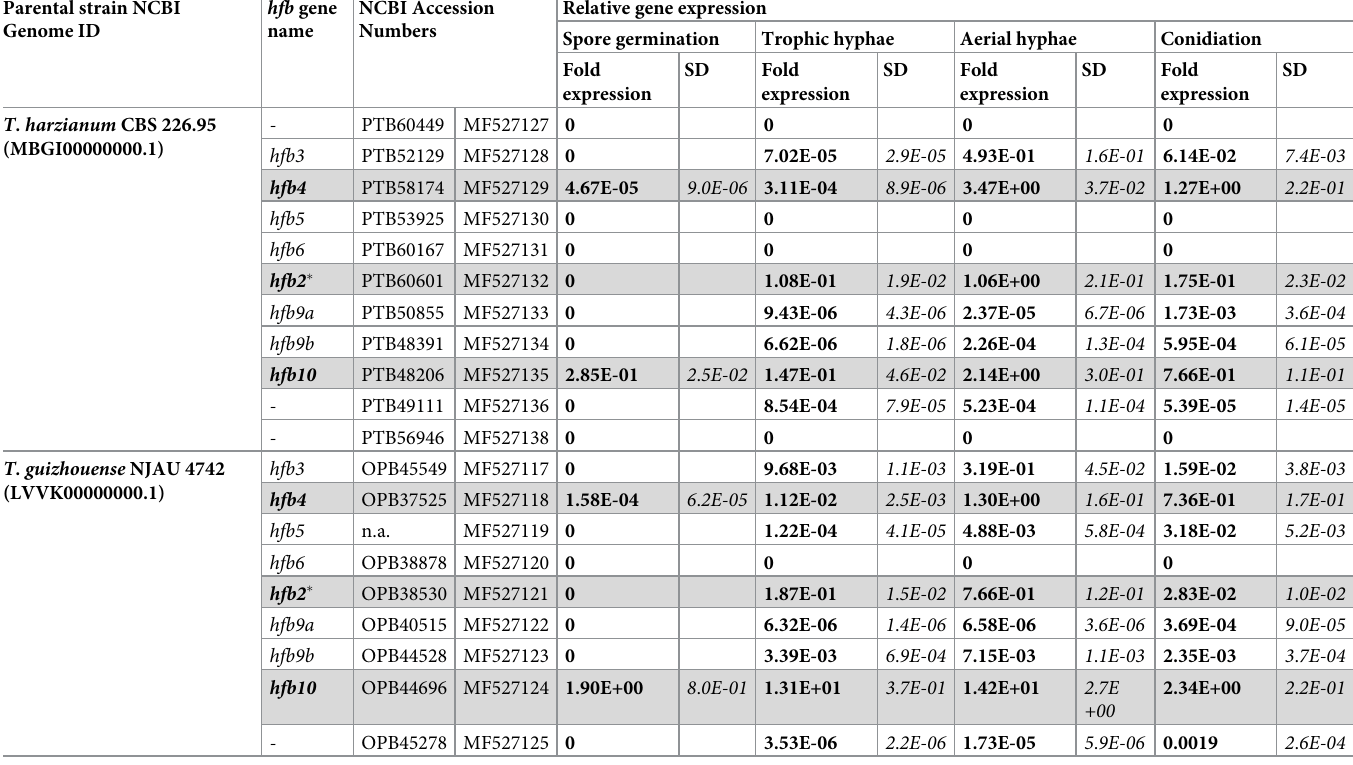
Table 1. Expression of hfb -encoding genes during four stages of Trichoderma development as quantified by qPCR in relation to the housekeeping gene tef1 [1]. The complementary principal component analysis is shown in S1 Fig. Parental strain NCBI Genome